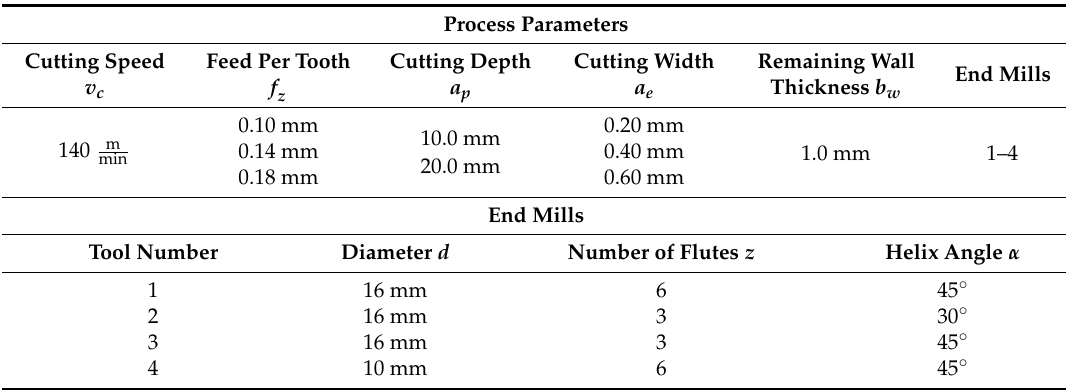
Table 1. Process parameters and end mills used for the milling experiments.